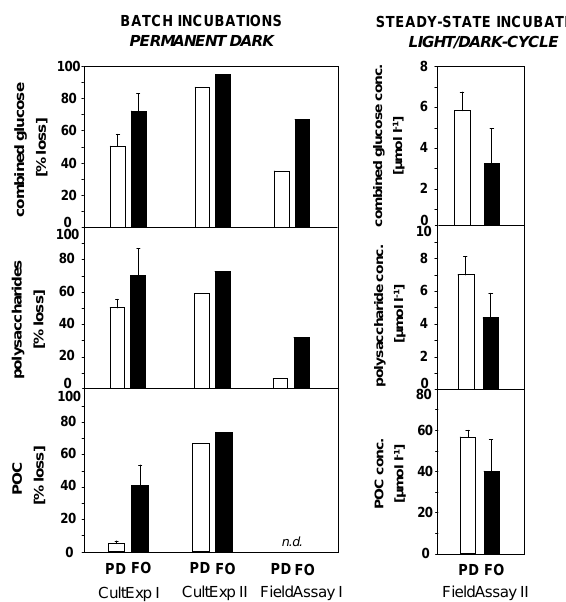
Fig. 1. Degradation of polysaccharides and organic carbon at present-day and future-ocean pH. Combined glucose ( > 1kDa), polysaccharides ( > 1kDa), and Particulate Organic Carbon (POC) were determined in reference incubations (open bars, PD: present- Figure 1 day pH) and at lowered seawater pH (solid bars, FO: future-ocean pH). In FieldAssay I, samples from replicate incubations were pooled for analysis. For the experiments CultExp I, CultExp II, and FieldAssay I, losses were calculated by subtracting the resid- ual from the initial concentration (n.d.: no loss detectable). Sig- nificance of differences between the pH treatments was assessed by means of paired t -tests (combined glucose: p =0.026; polysac- charides: p =0.005). Data of CultExp I, CultExp II, and FieldAs- say I were compiled for statistical tests. For the chemostat experi- ment FieldAssay II concentrations under steady state conditions are given. Error bars denote the standard deviation from replicate incu-